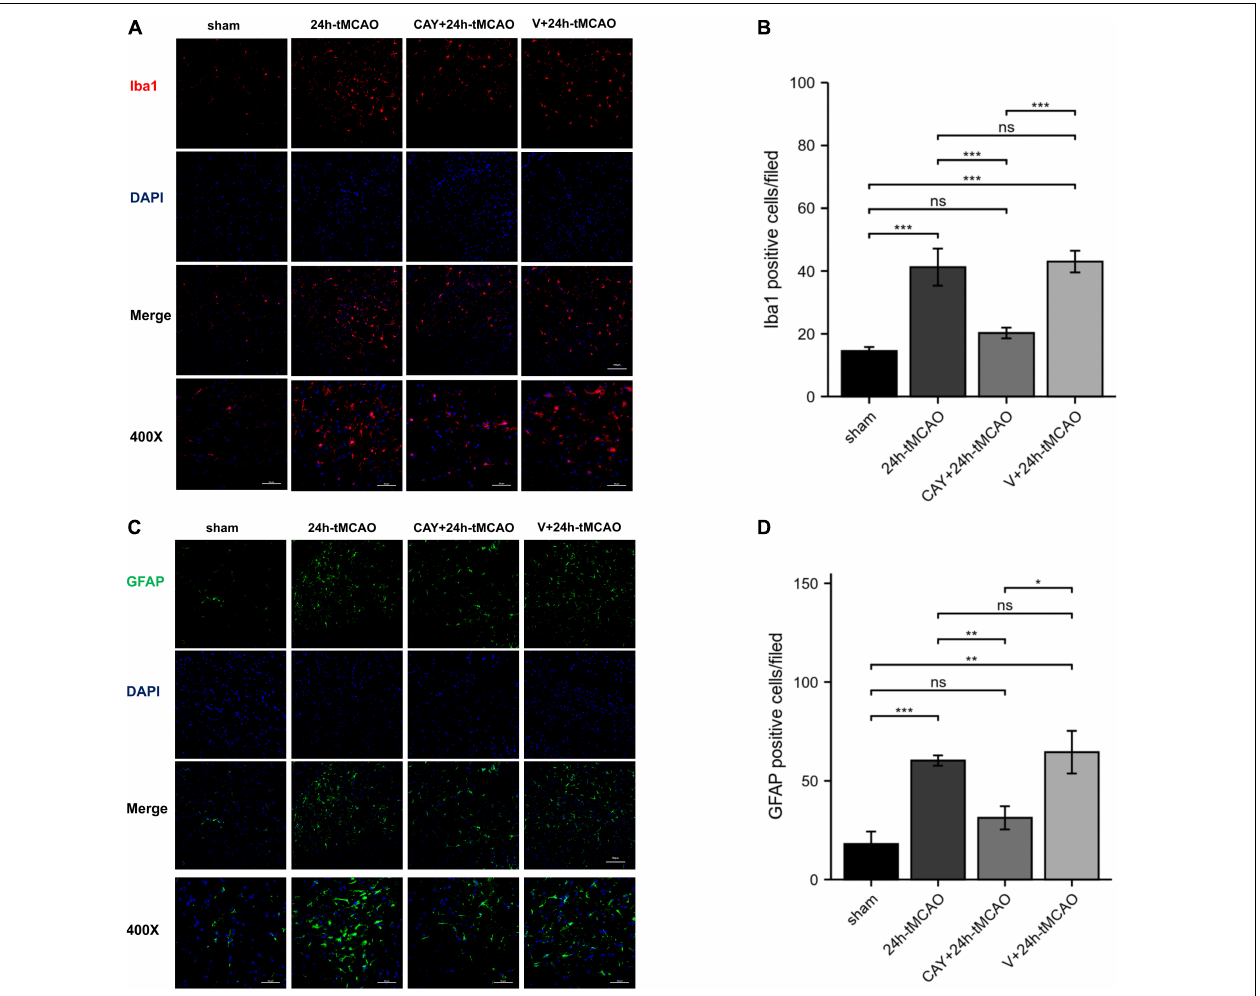
FIGURE 3 | Inhibition of S1PR3 attenuates microglia and astrocyte activation after tMCAO. (A,B) DAPI (blue)/Iba1 (red) Representative immunofluorescence images and statistical results of mouse brain tissue slices after tMCAO ( n = 4). (C,D) DAPI (blue)/GFAP (green) Representative immunofluorescence images and statistical results of mouse brain tissue slices after tMCAO ( n = 4). Data are presented as the mean ± SEM. P -values were determined by ANOVA followed by the Tukey post hoc test, * P < 0.05; ** P < 0.01; *** P < 0.001; and ns, not significant. Scale bar = 100 µ m. 400 × , Scale bar = 50 µ m.